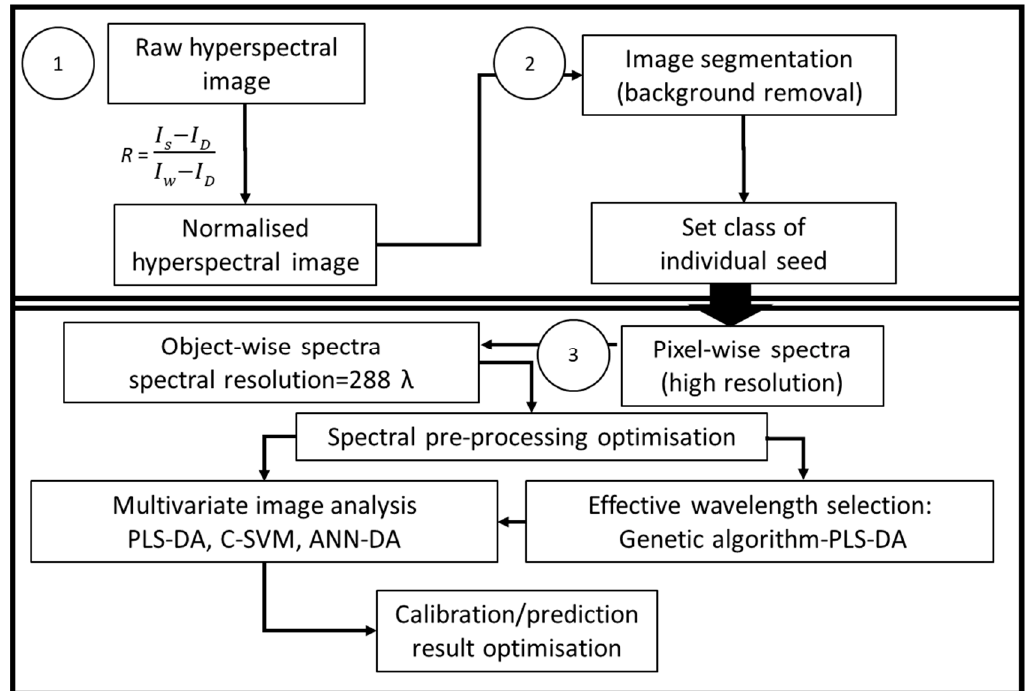
Figure 1. Flow chart of steps for analysing raw hyperspectral image of seeds. (1) Normalisation of image based on white and dark reference; (2) Image segmentation for background removal; (3) Spectral pre-processing and classification model development.